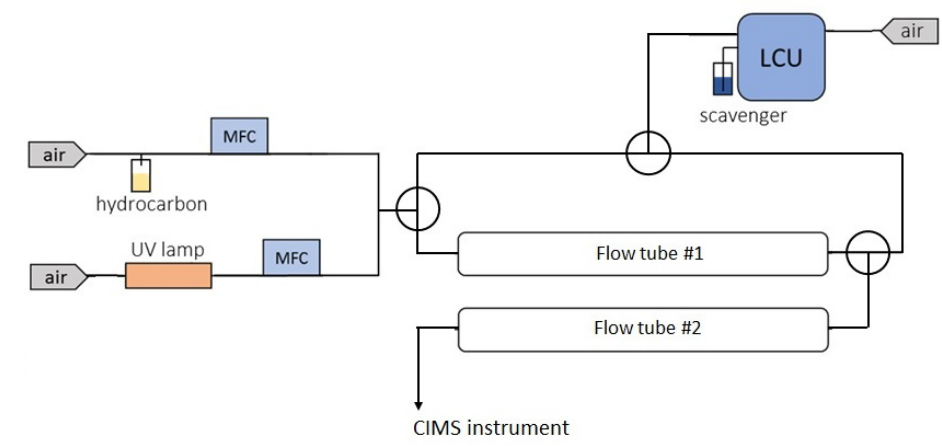
Figure 2. Schematic of the experimental setup used to detect SCIs and RO 2 with the spin trap DMPO. DMPO was introduced in the experimental setup using a liquid calibration unit (LCU, IONICON